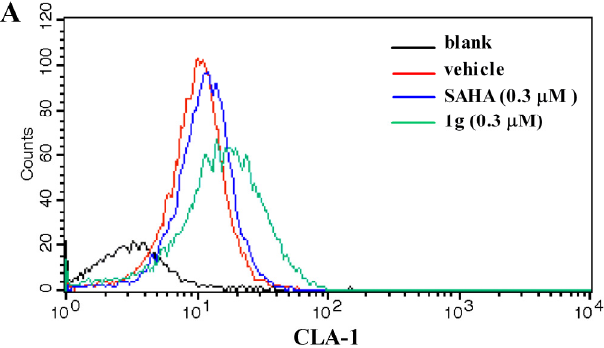
Figure 3. Effect of compound 1g on CLA-1 expression and DiI-HDL